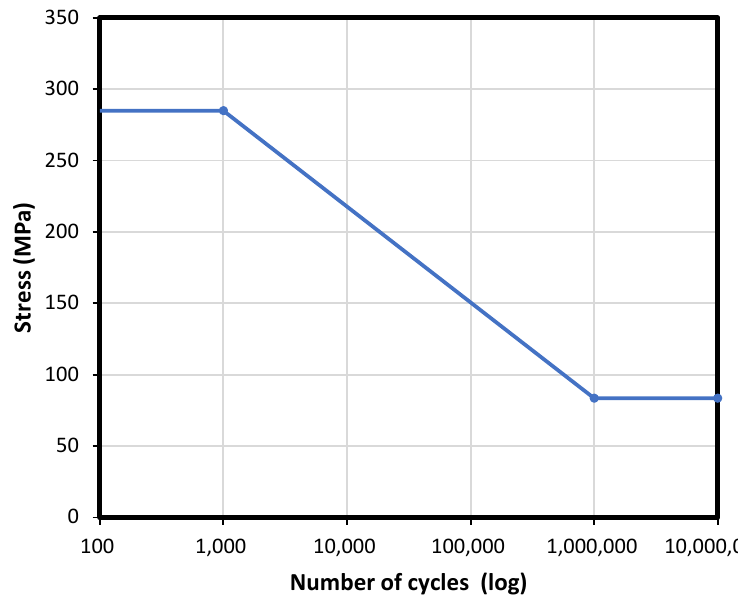
Figure 10. An S-N curve for the transplanting device material.